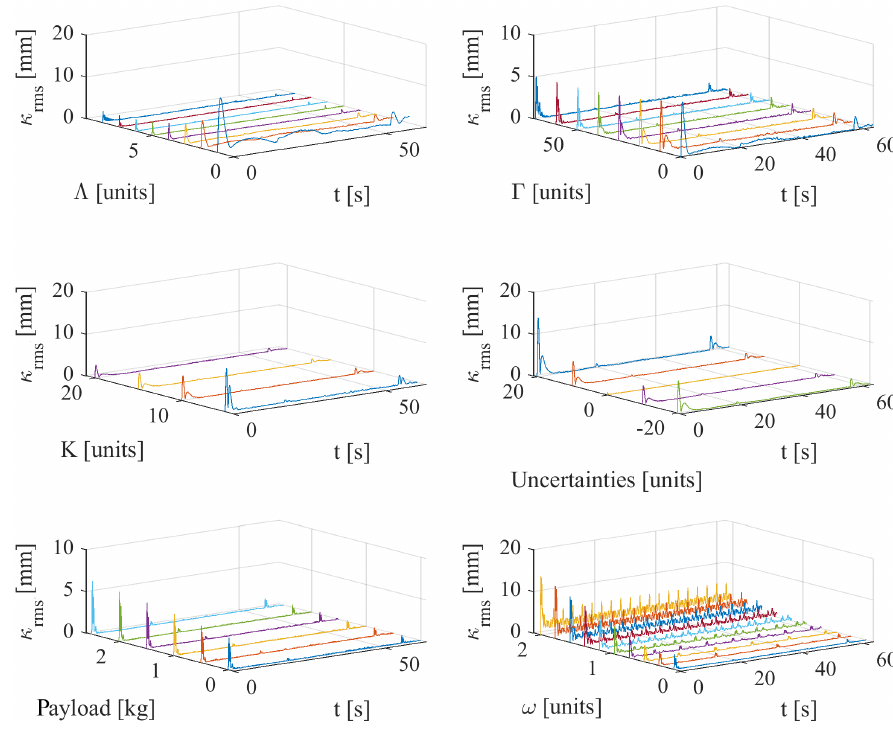
Figure 10. Sensitivity and robustness analysis results: Time trajectories of the norm of the end-effector position errors.